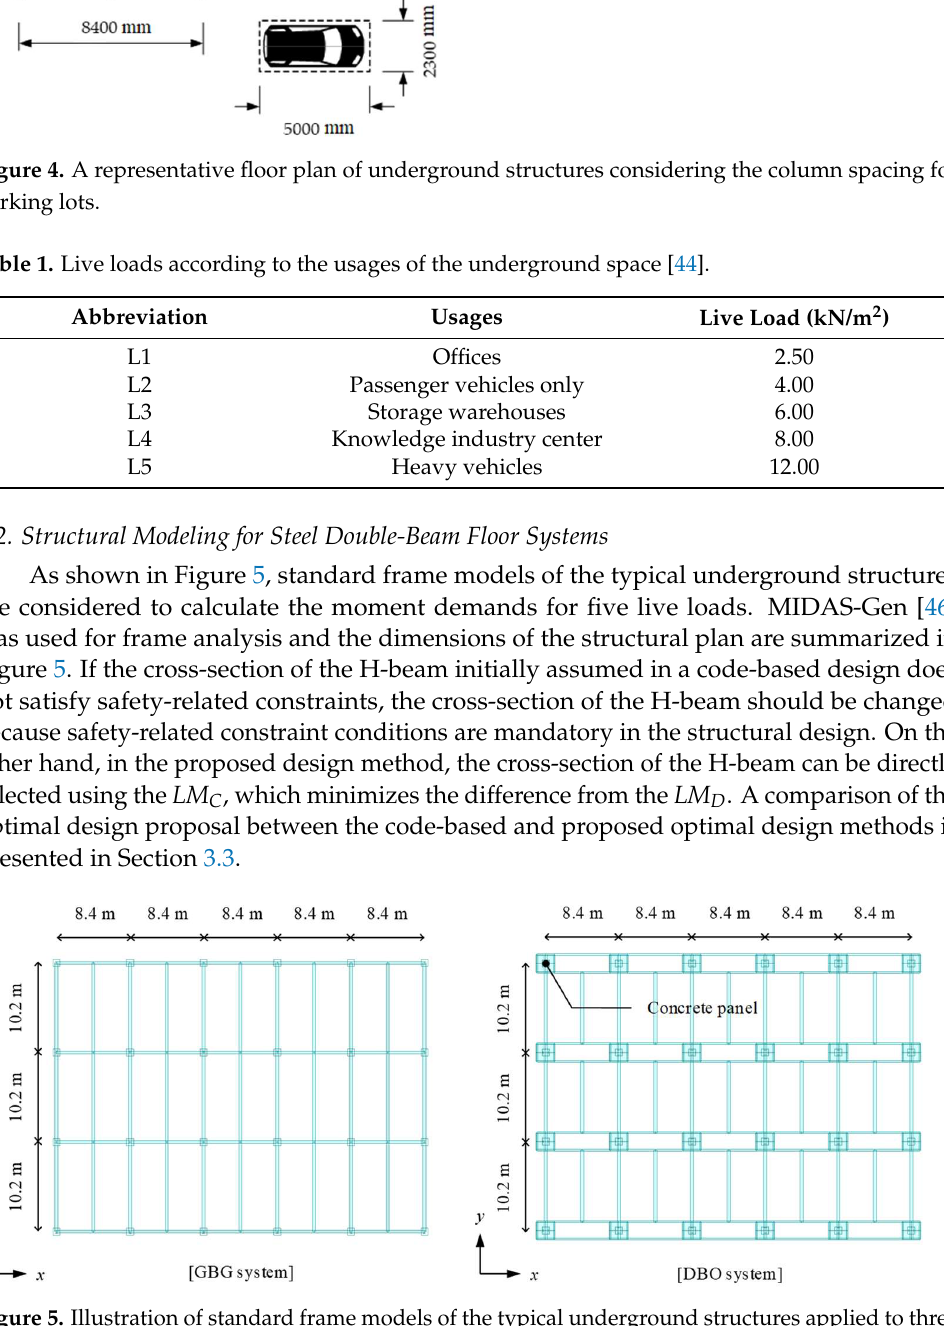
Figure 5. Illustration of standard frame models of the typical underground structures applied to three different floor systems (Note that the DBX system has the same configurations as the DBO system except for the concrete panel).